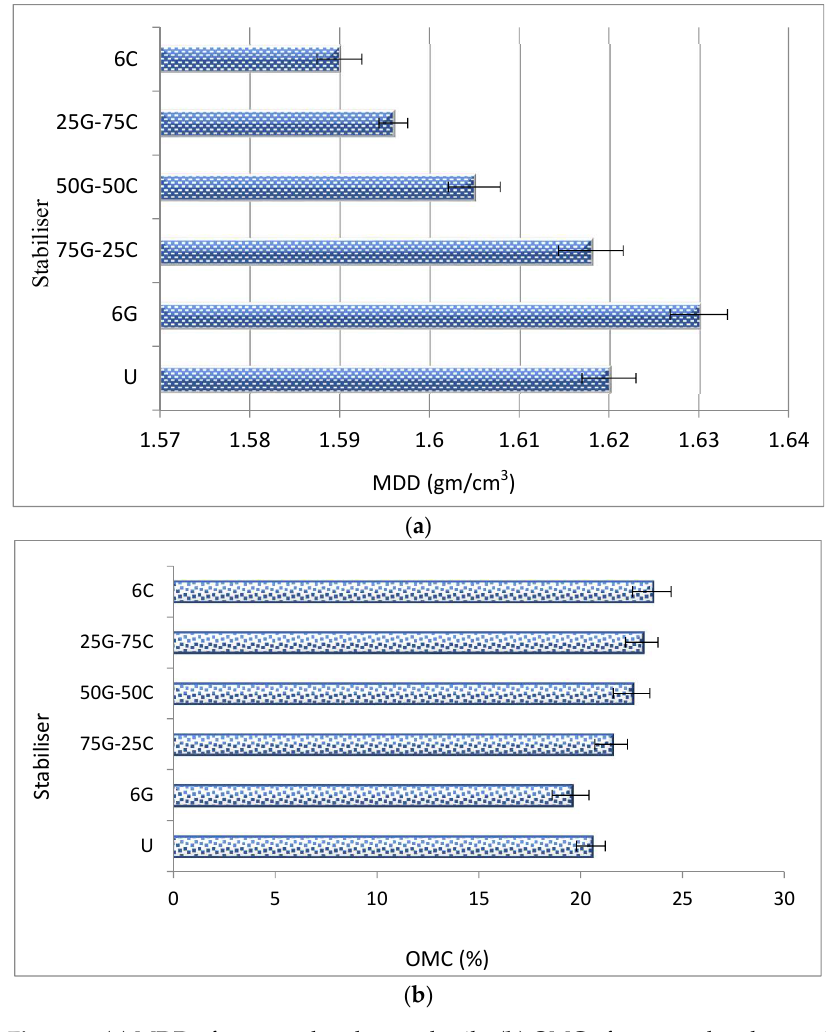
Figure 6. ( a ) MDD of untreated and treated soils; ( b ) OMC of untreated and treated soils.